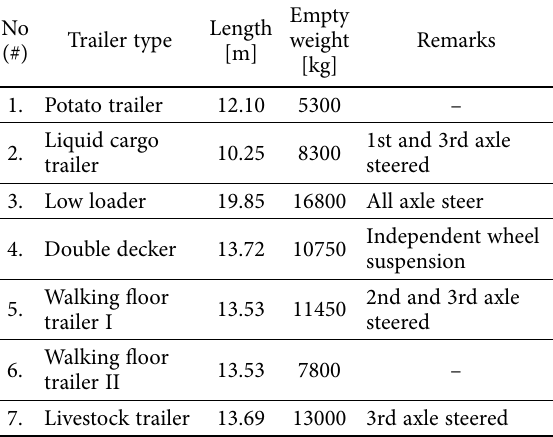
Table 1. Trailers used in the